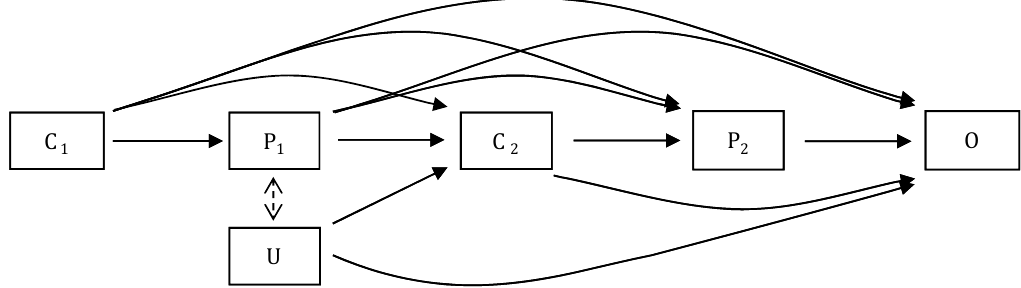
Figure 1 . Conventional Pathways Linking Exposure to Poverty to Child Educational Attainment Note : P = exposure to poverty, C = age‐varying covariates, O = child educational attainment, and U = unobserved factors.